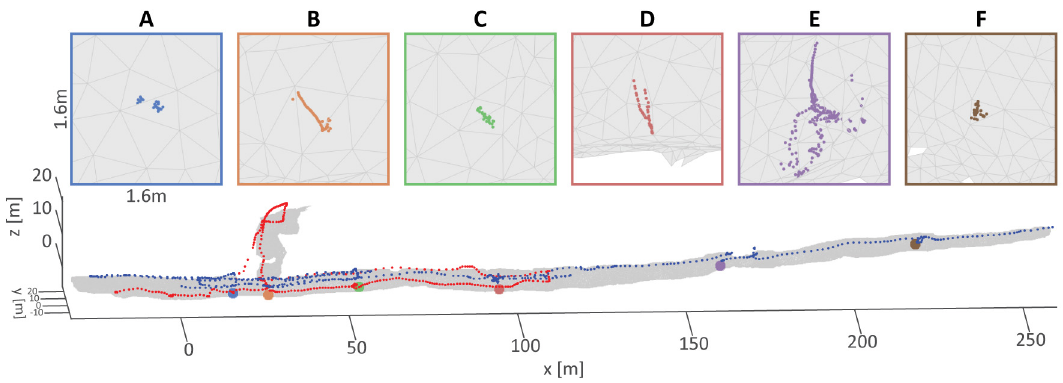
Figure 24. 3D reconstruction with the distribution of laser observations per segment for AUTT28 area. Blue and red dots correspond to VICTOR dives 654 and 658.